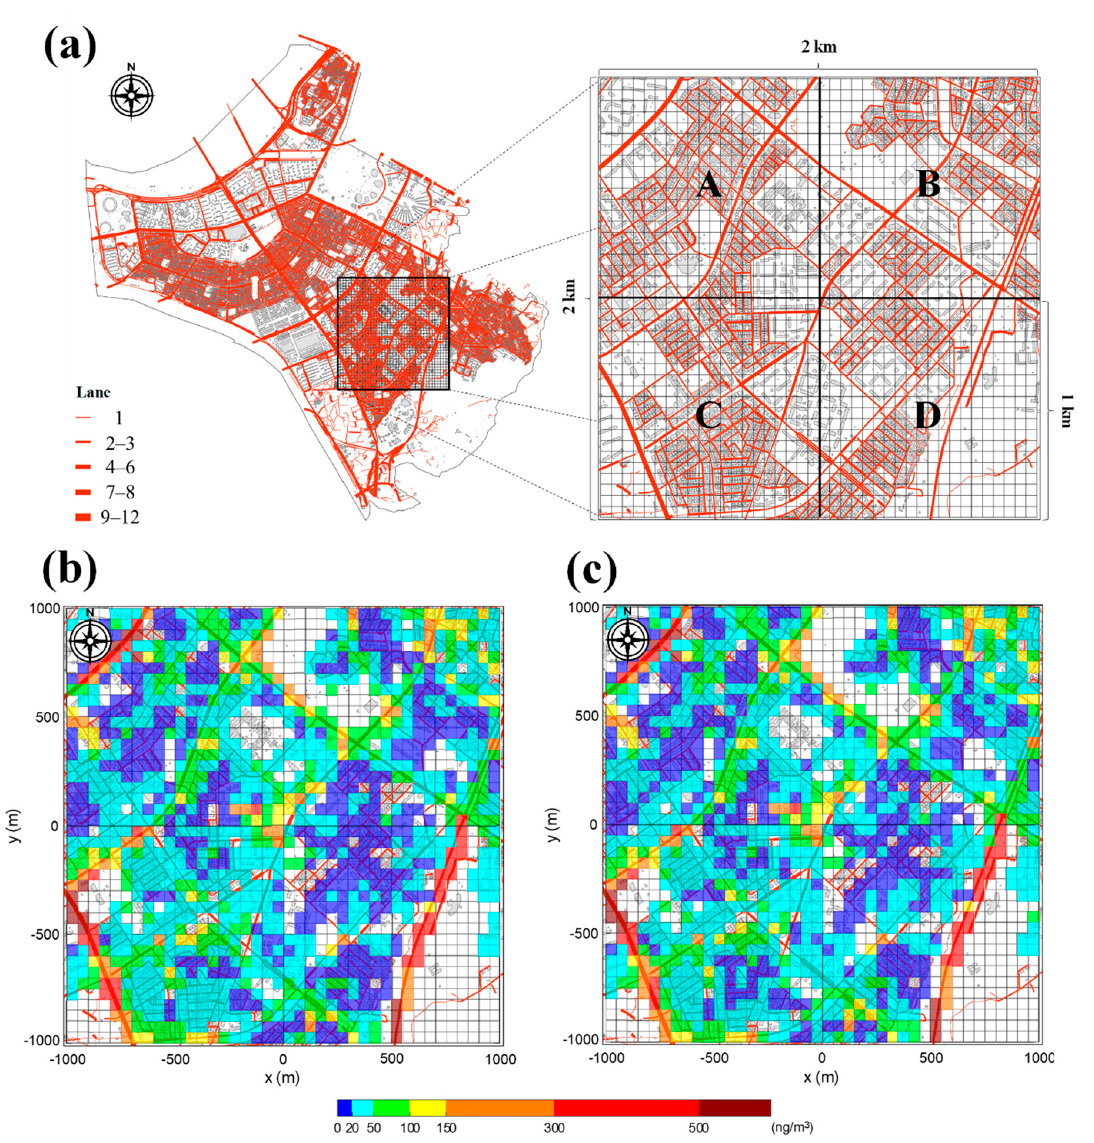
Figure 4. ( a ) Roadway map and study domain in Songpa-gu district. ( b ) Uncorrected and ( c ) corrected 2-D gridded air pollution map with seven pPAH concentration levels.